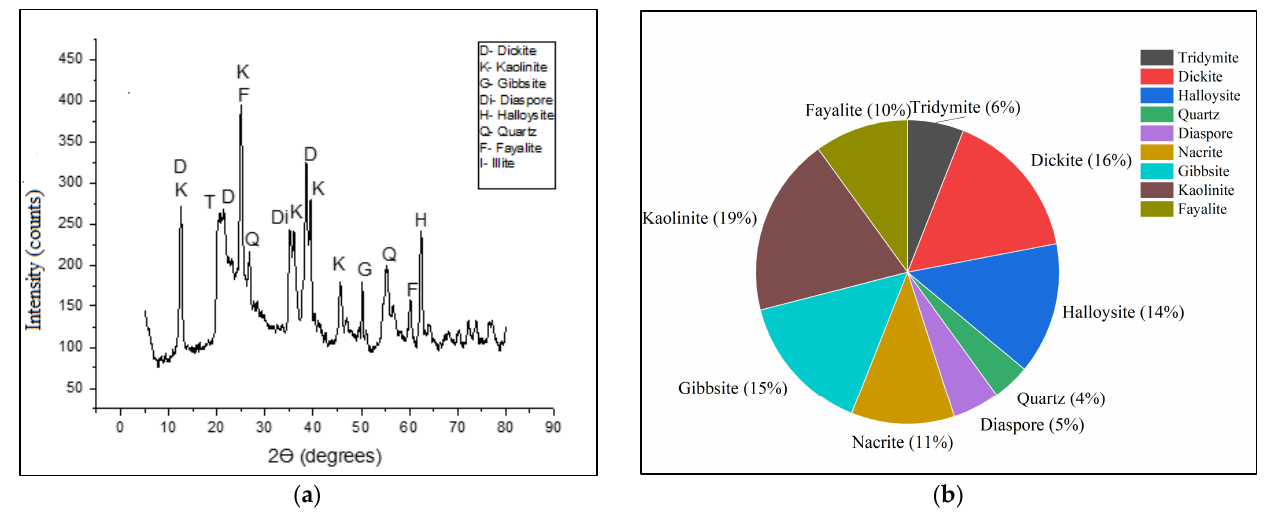
Figure 10. Characterization of minerals and compounds; ( a ) XRD analysis of Kolalgiri sample, ( b ) quantification of